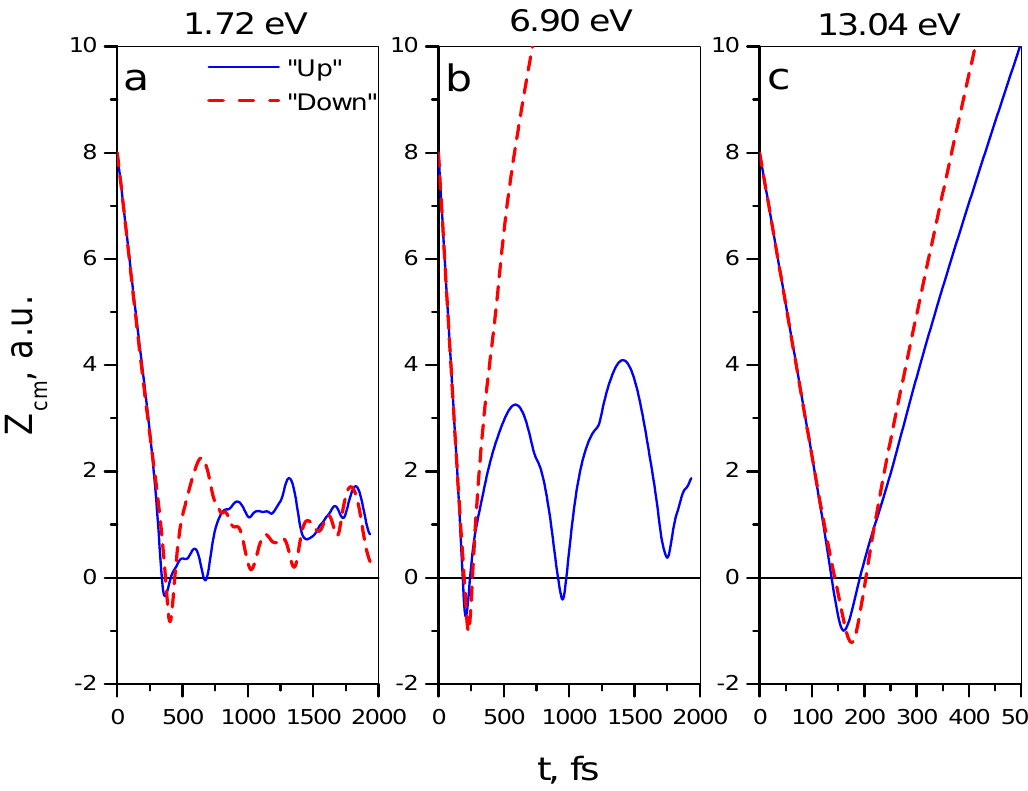
Figure 3: Time evolution of center of mass of the cluster during the deposition process for the initial kinetic energies a) 1.72 eV, b) 6.90 eV and c) 13.04